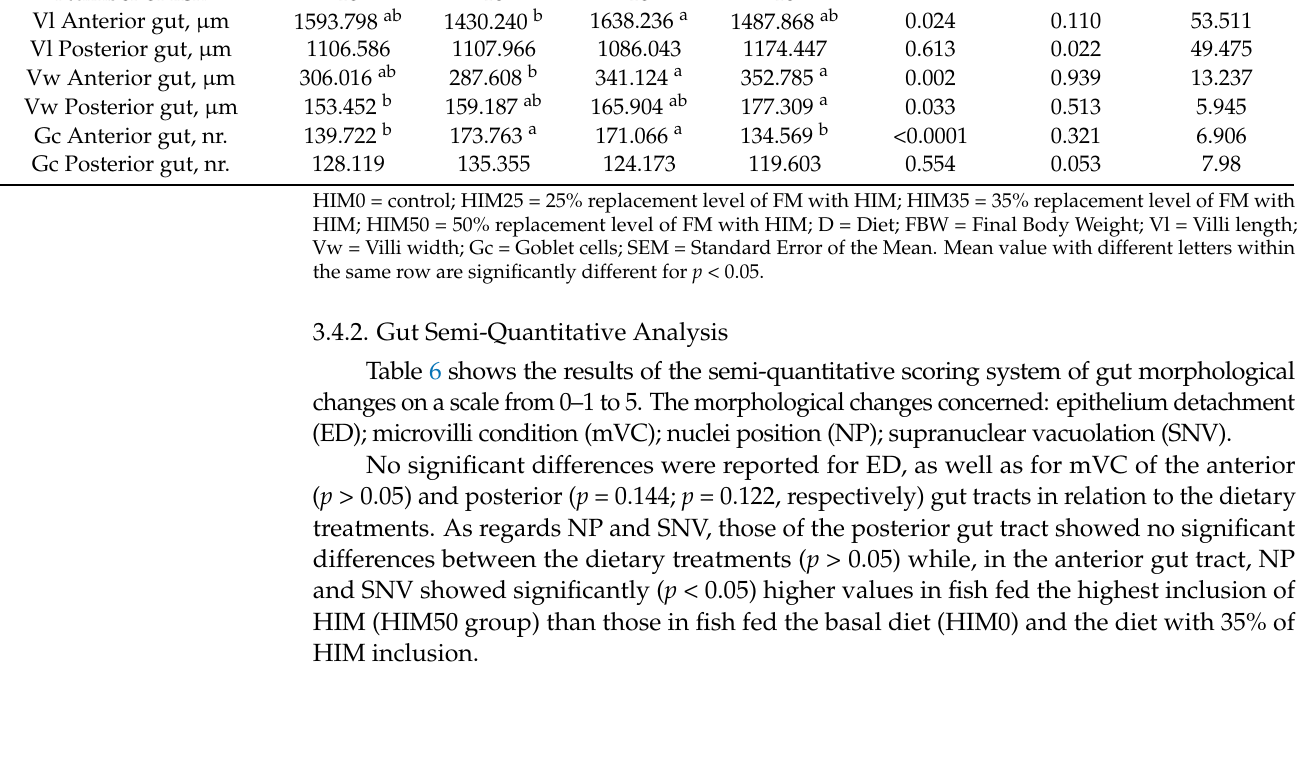
Table 5. Intestinal morphometric parameters of gilthead seabream fed experimental diets. GROUP p -Value HIM0